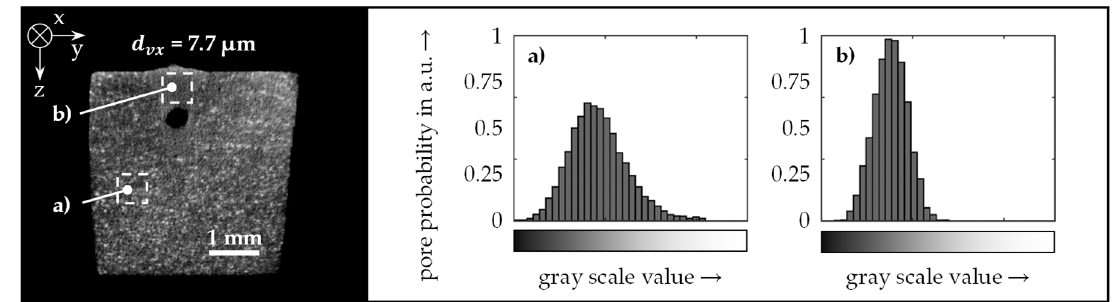
Figure 6. Gray value distribution of a cross ‐ sectional evaluation of a μ CT scan with a voxel size d vx of 7.7 μ m for a representative area of the base material ( a ) and the weld seam ( b ); material AA 2219, laser power 1.5 kW, feed rate 9 m/min.